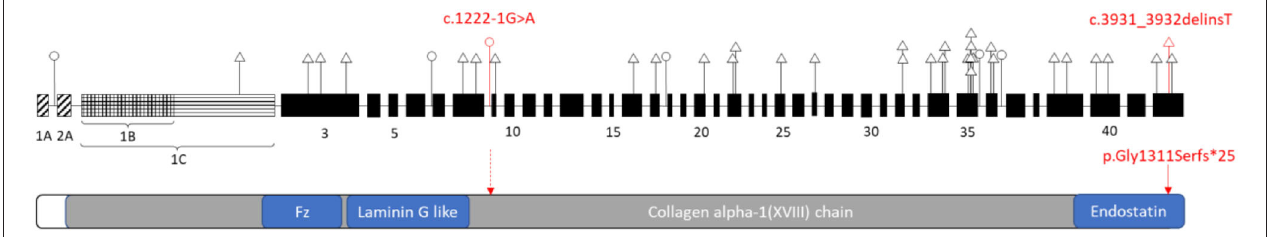
FIGURE 3 | Schematic representation of the distribution of reported variants identified in COL18A1 gene (top) related to the functional domains of the Type XVIII collagen (bottom). COL18A1 gene (top): A, B, C indicated three isoforms: NM_001379500, NM_030582, NM_130444 respectively. The numbers indicated the exons. Triangle, variants in the coding region; Circle, variants in the non-coding region. Red labeled variants are the ones reported in this study. Please refer the other variant details to Supplementary Table 1